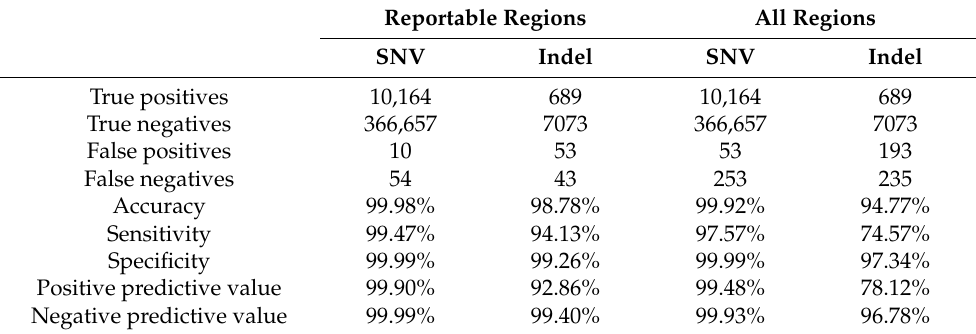
Table 5. Accuracy, sensitivity, and